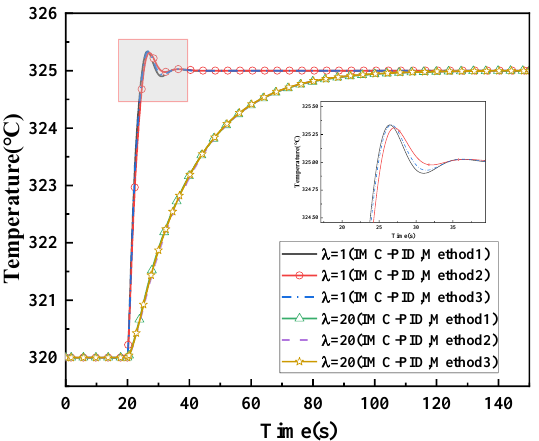
Figure 11. Comparison of IMC-PID performance of different methods.